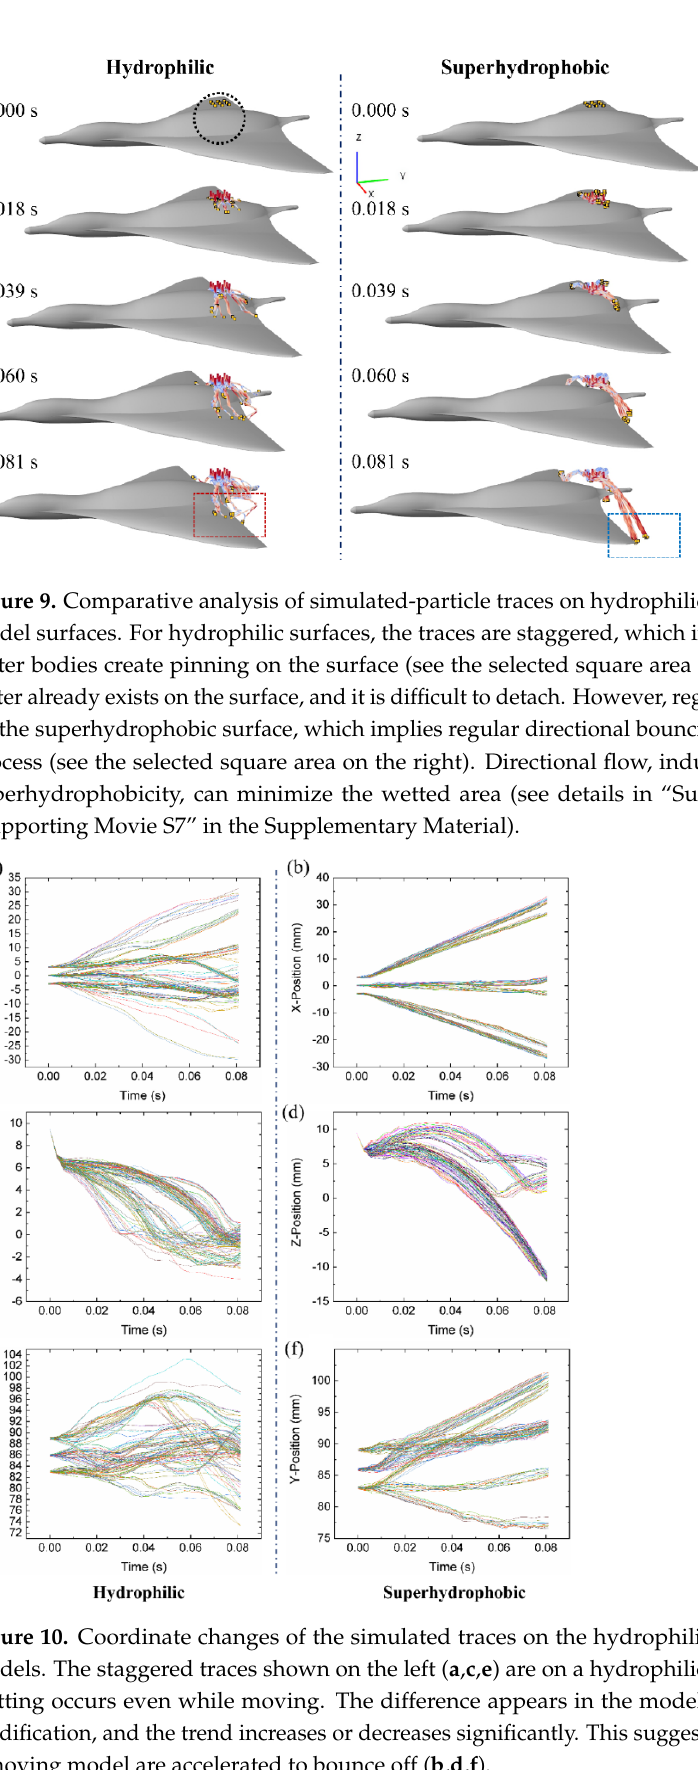
13 of 17 Figure 8. Comparison of the effects of surface curvature and wettability on lateral-pressure distri- bution. Water adhering to the hydrophilic surfaces of the wings quickly creates areas of high pres- sure on the wings, but asymmetrically, which induces nonequilibrium mechanical flight penalties. However, the coupling of superhydrophobicity to the surface curvature can disperse the impact force, no obvious high-pressure region is observed on the superhydrophobic surface, and the lateral interference is thus weakened (see details in “Supporting Movie 5” and “Supporting Movie 7” in the Supplementary Material). 4. Discussion Effects of Surface Wettability and Motion on Liquid Adhesion and Bouncing Behavior The traces of fluid particles [40] can reveal the intrinsic flow behavior of droplets. Traces can be obtained by numerical solution (computer simulation, see “S3. Simulation Setup and Analysis” in the Supplementary Material). The left and right sides of the center line in Figure 9 are the analysis results of models with hydrophilic and superhydrophobic surfaces, respectively. The tracking target is determined by a cube with a size of 10 mm ×